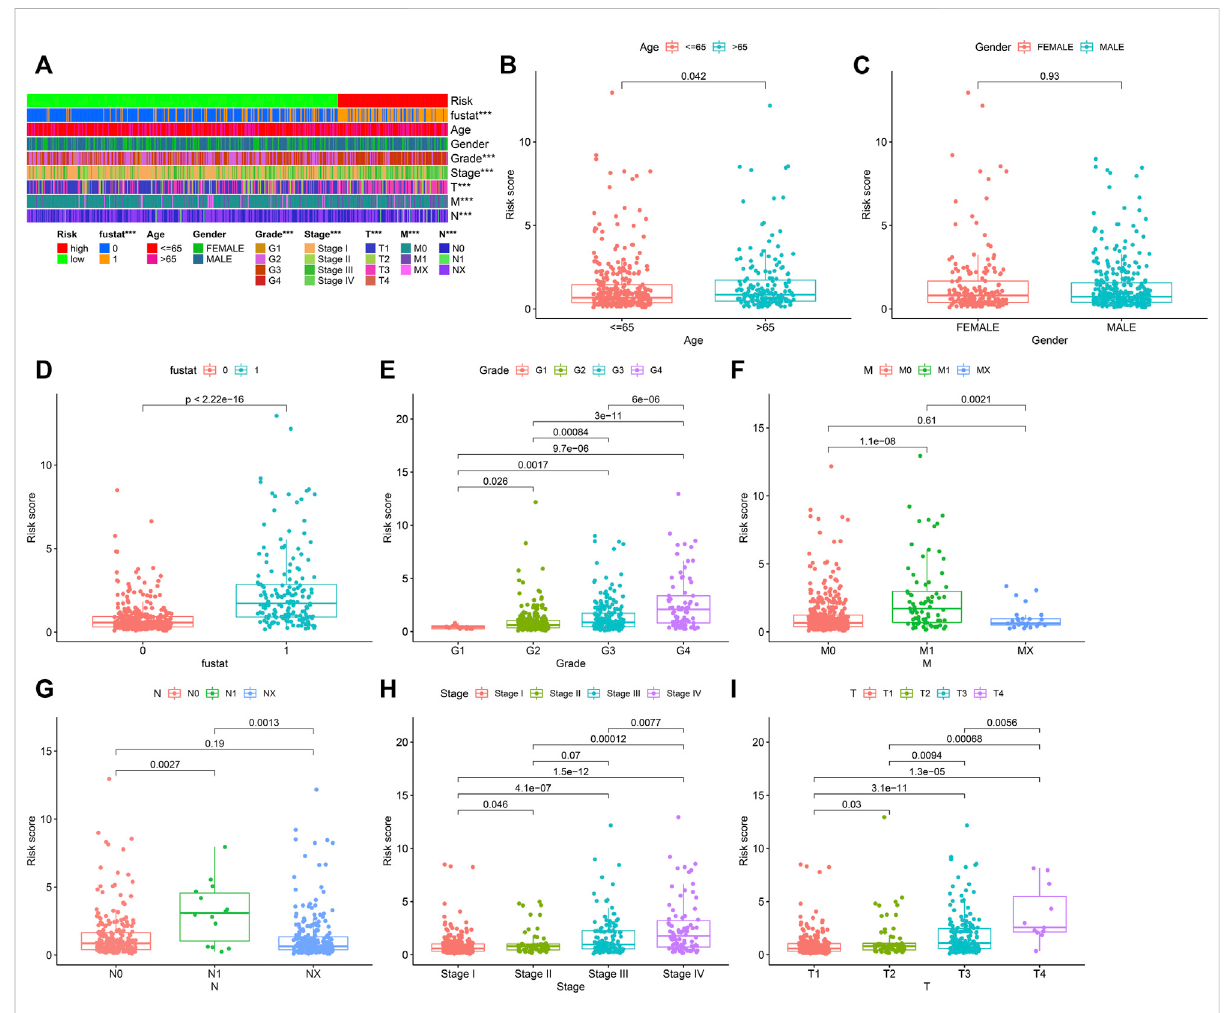
FIGURE 5 Collection of prognostic lipid metabolism-associated lncRNA hallmark and clinicopathologic features of ccRCC. (A) Heat maps of clinicopathologic features: survival status, age, gender, grade, stage, T, N and M in risk high and risk low sufferers. * p < 0.05; ** p < 0.01; *** p < 0.001. Comparison of risk score in diverse clinicopathologic features: (B) age ≤ 65 and > 65. (C) gender. (D) survival status (0: dead; 1: alive). (E) grade. (F) M. (G) N. (H) stage. (I)